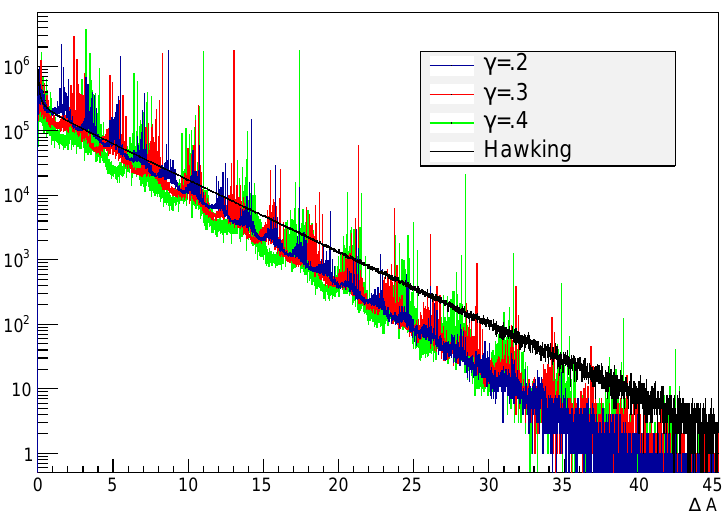
Figure 2. Spectrum of a holographic black hole for different values of γ as a function of ∆ A . From [44].